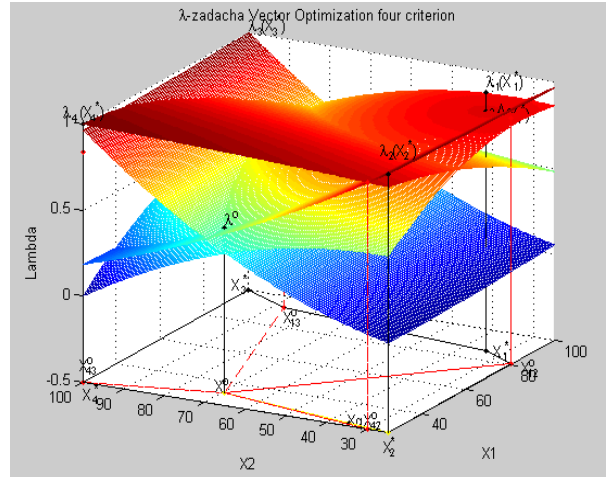
Figure 7. The solution of the λ -problem in a three-dimensional system of coordinates of x1, x2 and λ